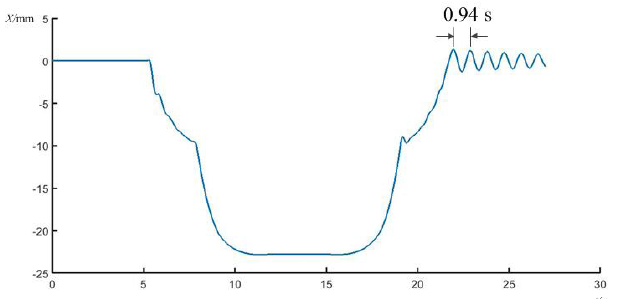
Figure 27. x -axis displacement of the platform.